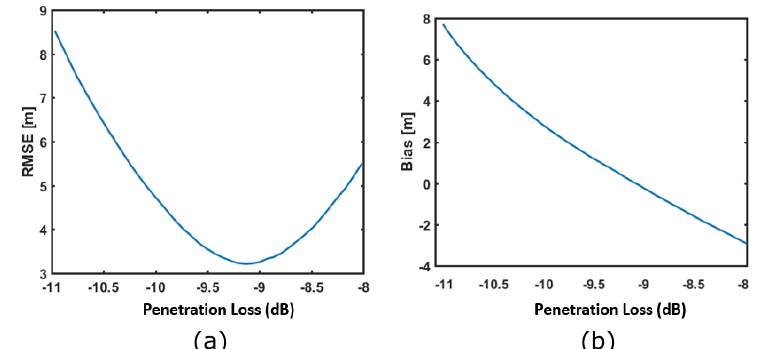
Figure 9. ( a ) Forest top height root mean square error (RMSE) and ( b ) bias versus penetration loss with respect to noise floor elevation.